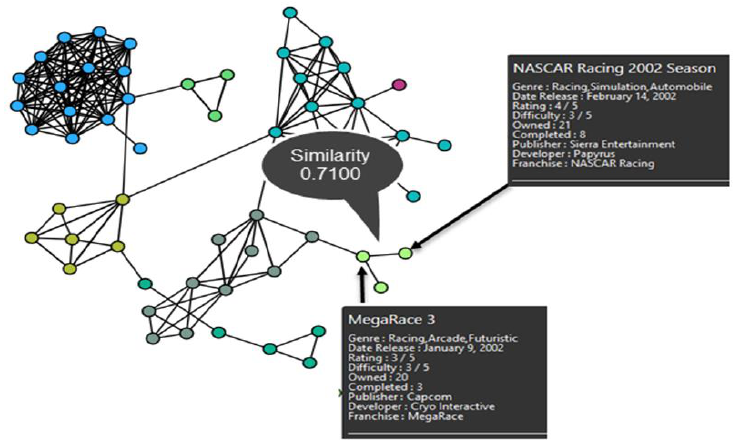
Figure 2. Example of our graph.